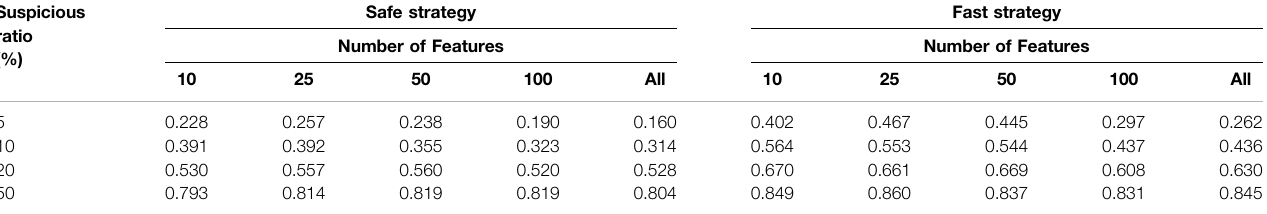
TABLE 12 | Recall scores ’ p -values between different suspicious ratios.